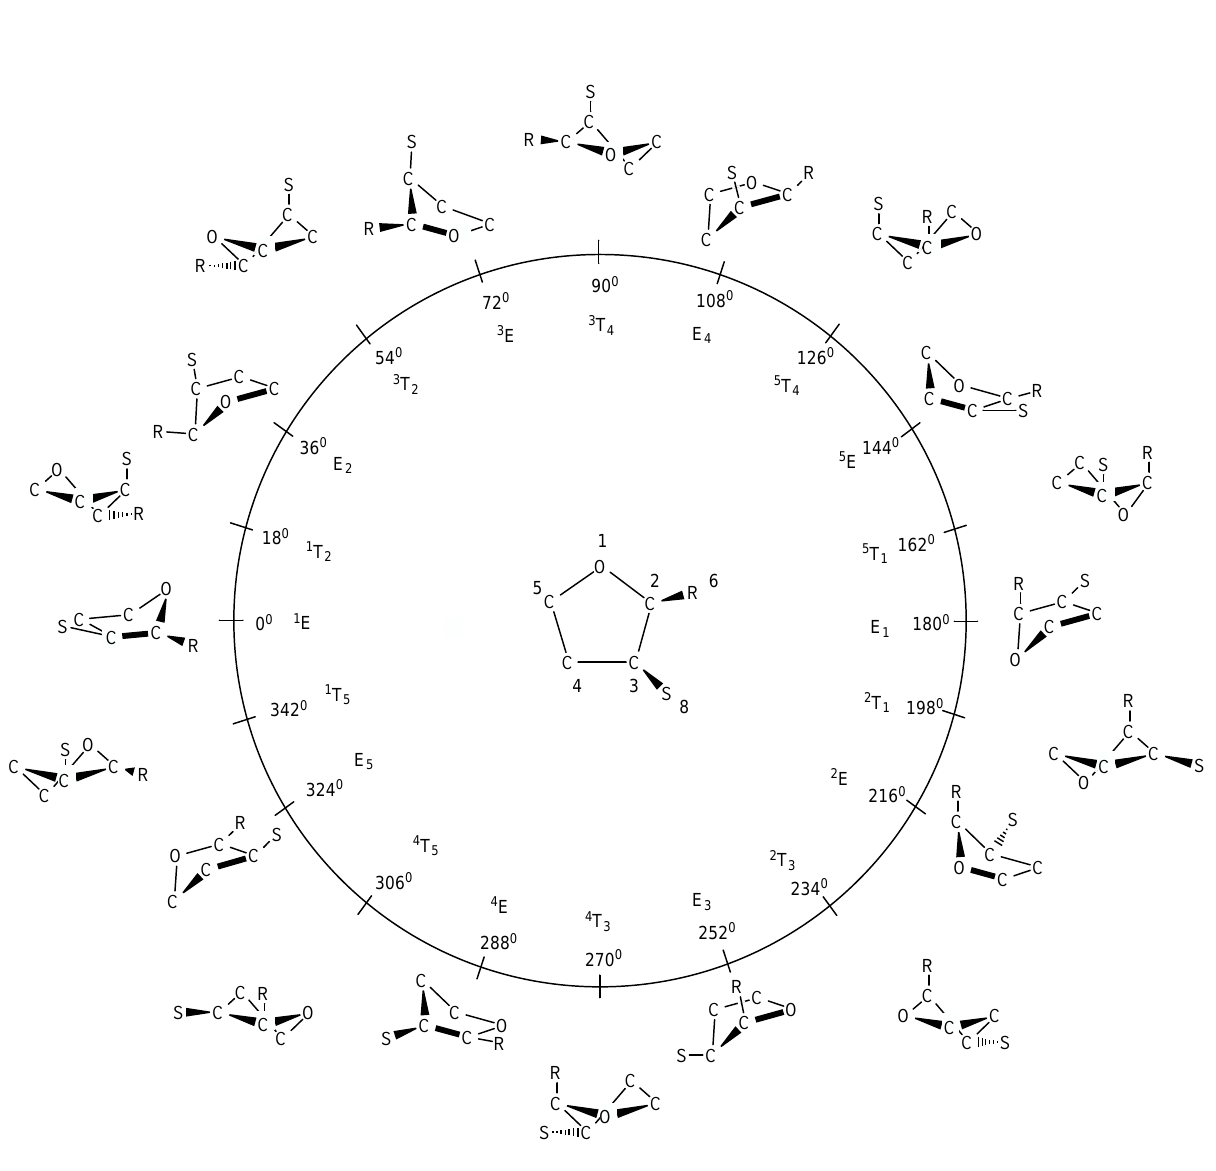
Figure 1: Pseudorotation itinerary ( φ = 0 → 360 ◦ ) of tetrahydrofuran (THF) as indicated by the 10 E and ten T forms at φ = (0 + k*360)/10 and φ = (18 + k*360)/10 (k = 0,1,2,...,9). At the center (q = 0), the planar ring is located. To distinguish different positions in the ring, symbols R, S are used for